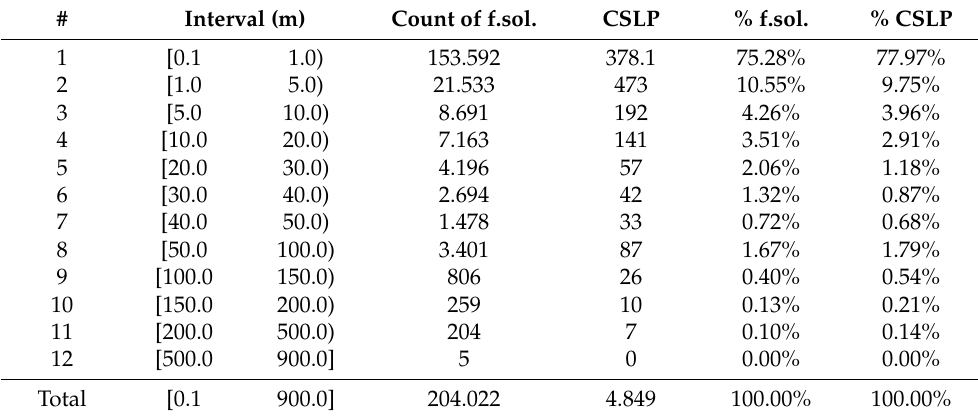
Table 2. Distribution of the size of